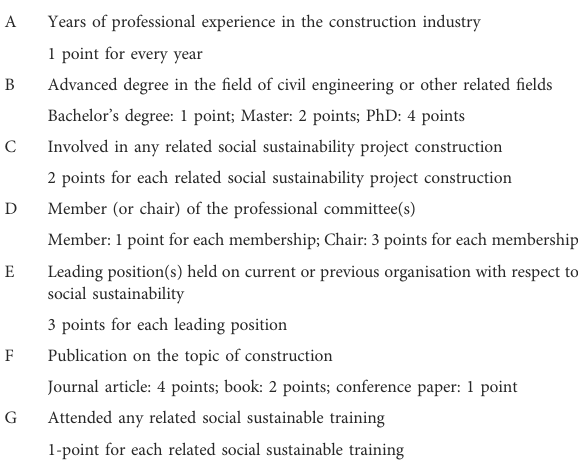
TABLE 2 Point system for the quali fi cation of expert